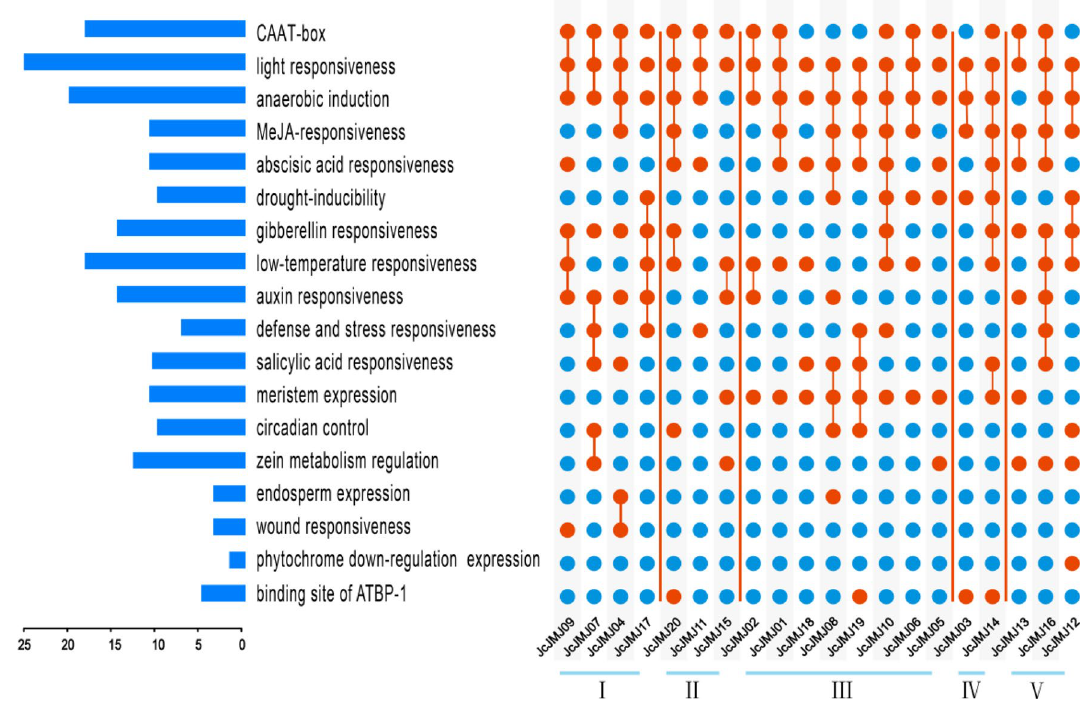
Figure 6. Cis-acting elements in the promoters of each JcJMJ gene. The length of the blue bar on the left indicates the number of cis-acting elements; The blue origin on the right indicates the site in the promoter of the gene that does not have the cis-acting element, while the red color indicates the site that does.